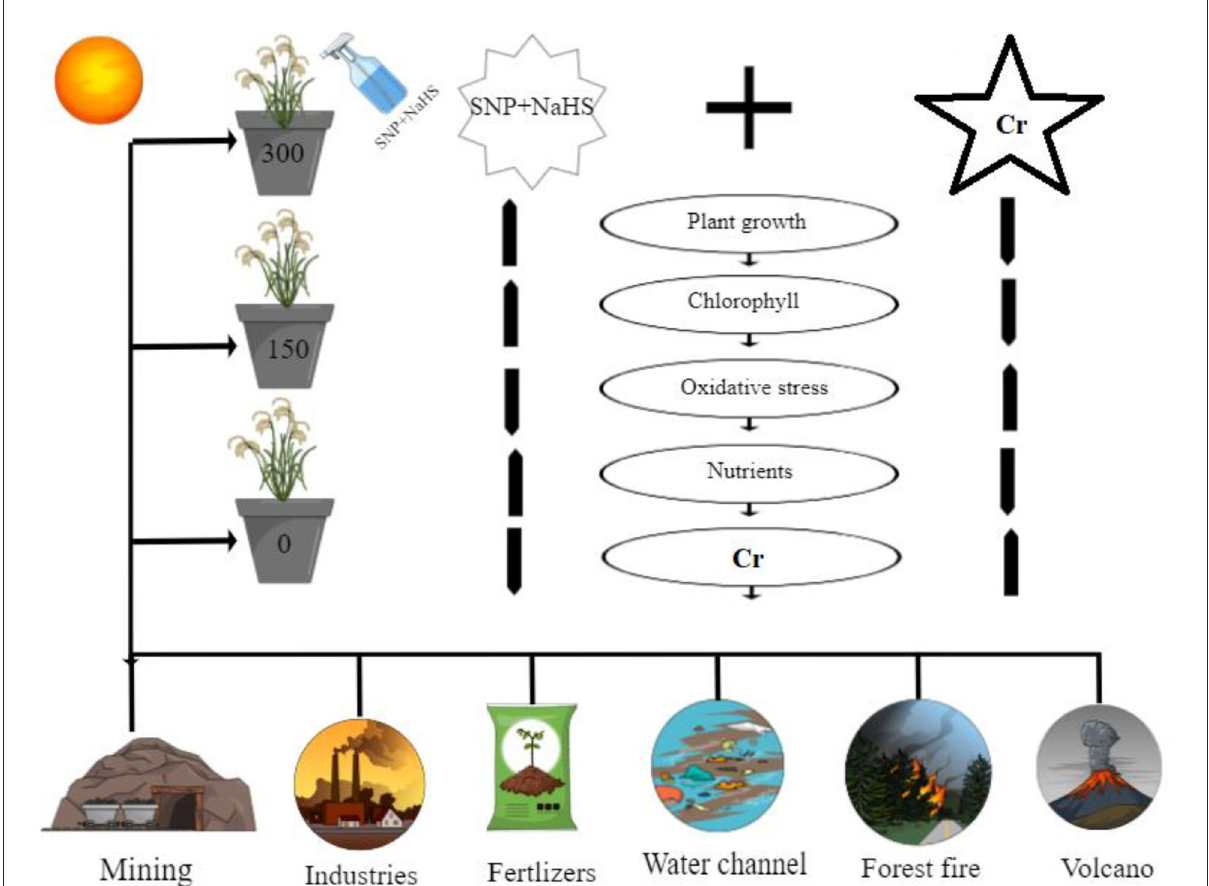
FIGURE10 Schematic presentation of the findings from this study under the individual/or combinatorial application of SNP and NaHS in Cr-stressed spinach ( S. oleracea ) plants grown under different levels of Cr stress, i.e., 150 and 300 µ M, in sandy loam soil. The figure shows Cr sources in the natural soil and its toxic effects on the plants. The figure also shows that Cr toxicity can be overcome by the alone/or combinatorial application of SNP and NaHS, which decreased oxidative stress in membrane-bound organelles by decreasing Cr content in various parts of the plants. Overall, this scheme presents the complete description of this experiment and the important findings that we have evaluated from the application of SNP and NaHS in Cr-stressed spinach ( S. oleracea )